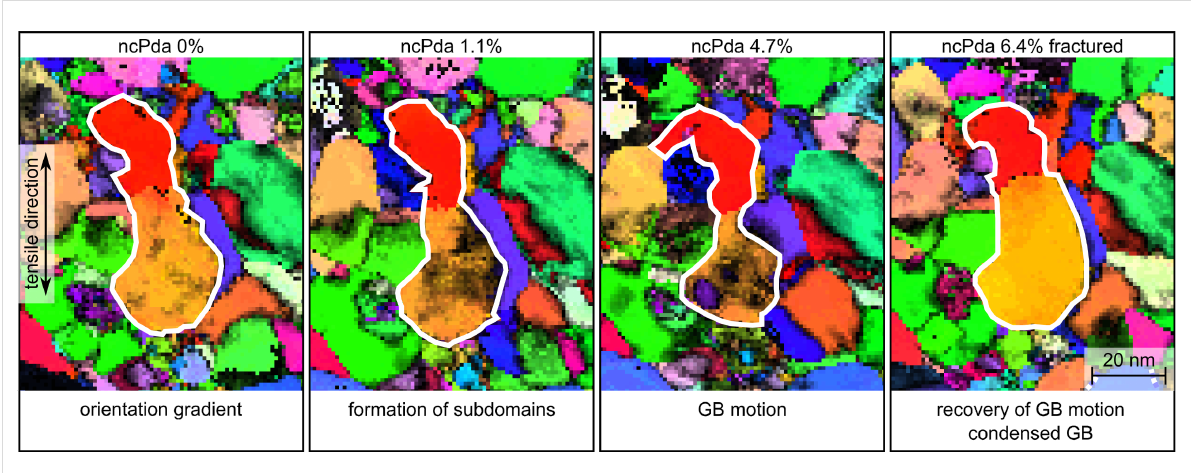
Figure 2: Grain fragmentation of the center grain (white boundary) during the tensile deformation (0–4.7% strain) of ncPda and grain recovery after fracture (6.4% strain) of the sample. The ACOM-STEM orientation maps overlaid with the reliability are shown for selected straining states with the projection direction along the tensile direction and the color code is given in Figure